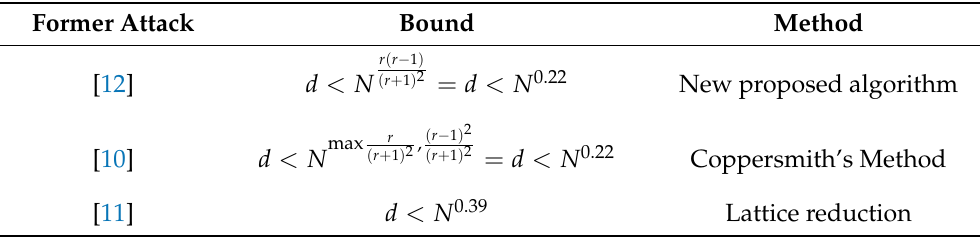
Table 1. Bounds for d from the former